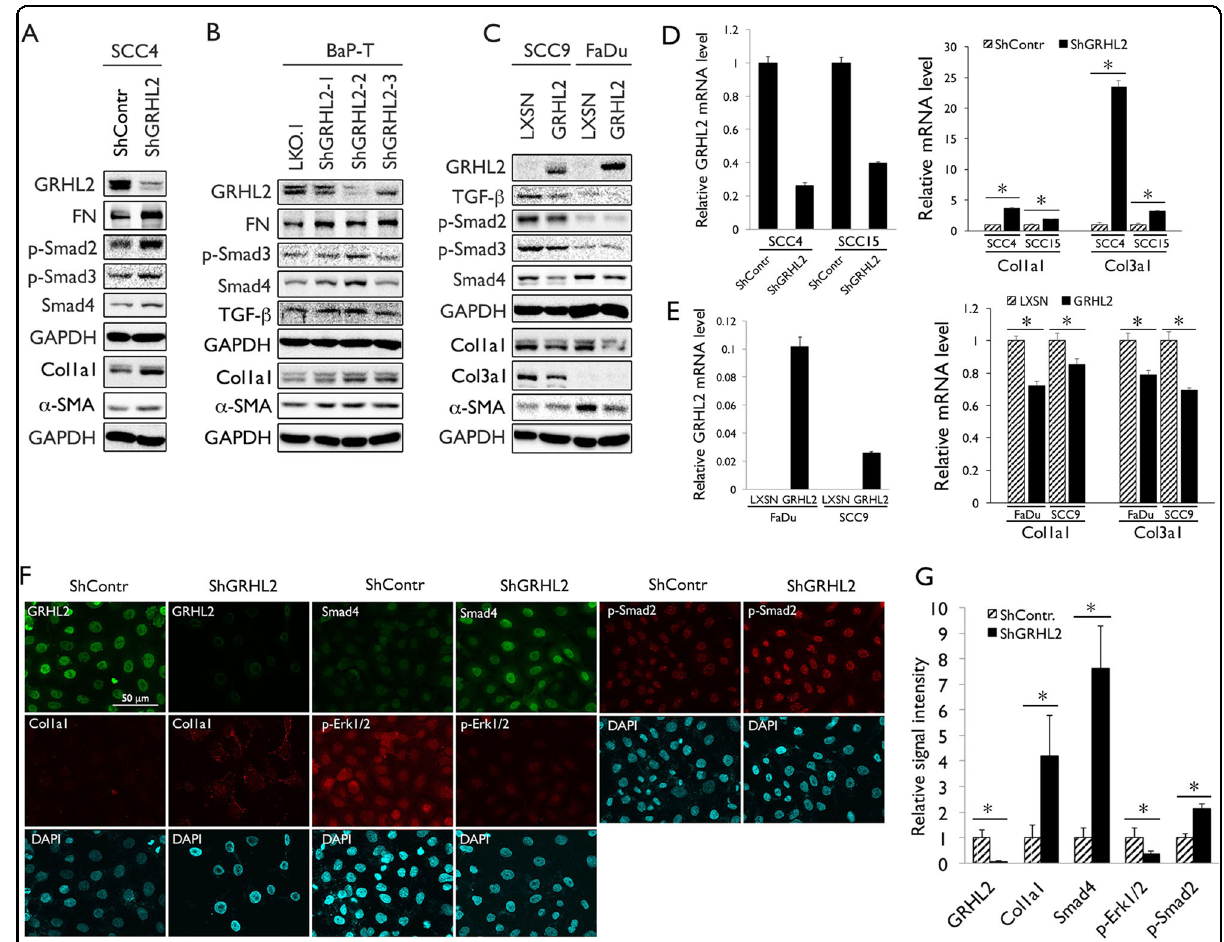
Smad2, p-Smad3, Smad4, Col1a1, and α -SMA, in whole-cell extracts of SCC4 and BaP-T cells infected with control lentiviral vectors (ShContr or LKO.1) or those expressing GRHL2 shRNA targeting different regions (ShGRHL2 and ShGRHL2-1,2,3). c GRHL2 was overexpressed in SCC9 and FaDu cell lines infected with retroviral vector expressing full-length cDNA of GRHL2 (LXSN-GRHL2) or the empty vector (LXSN) for GRHL2 and TGF- β signaling proteins, e.g., TGF- β , p-Smad2, p-Smad3, Smad4, Col1a1, Col3a1, and α -SMA. d qRT-PCR was performed for Col1a1 and Col3a1 in SCC4 and SCC15 cells after GRHL2 knockdown using the lentiviral vector (ShGRHL2). * P o 0.05, signi fi cant difference. e qRT-PCR was performed in SCC9 and FaDu cells after GRHL2 overexpression for Col1a1 and Col3a1. f IFS was performed for GRHL2, Col1a1, p-Smad2, Smad4, and p-Erk1/2 in SCC4 cells stably infected with Lenti-ShGRHL2 or the control vector (ShContr). g IFS signals were quantitated and plotted with the mean values for SCC4 cells with Grhl2 knockdown and its control cells. Bar indicates mean/SD. * P o 0.05, signi fi cant difference, compared with SCC4 infected with control